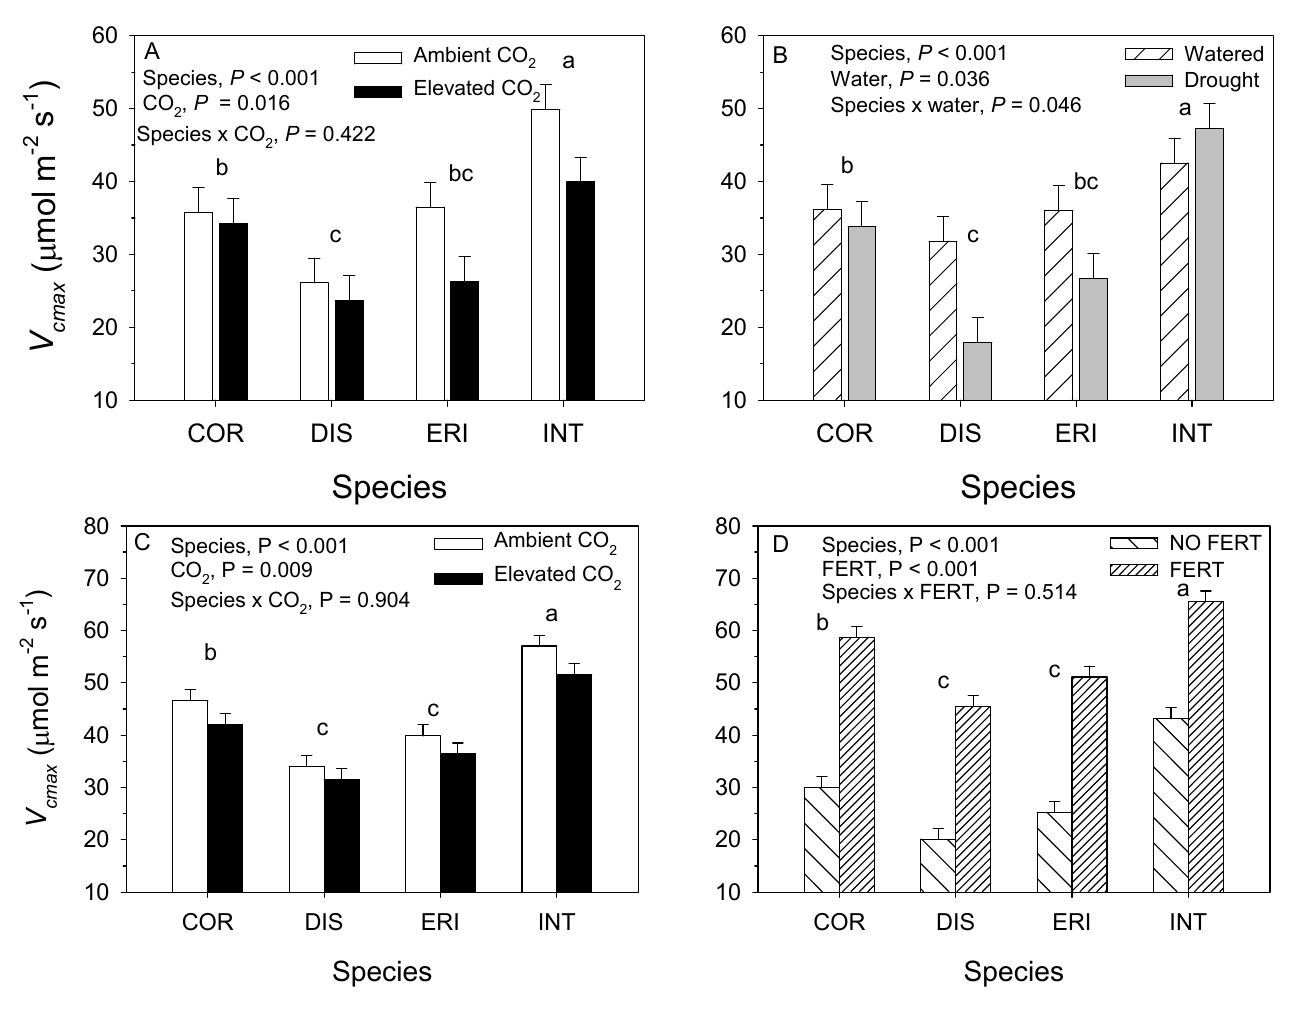
Figure 1. ( A ) Maximum rate of carboxylation ( V cmax ) (mean ± SE) by willow species and CO 2 treatments in 2017, ( B ) by willow species and moisture stress treatments in 2017, ( C ) by willow species and CO 2 treatments in 2018, and ( D ) by willow species and fertilization treatments in 2018. If lower case letters differ among willow species than significantly different using Tukey’s mean separation test ( p = 0.05). Table 2. Assimilation to internal CO 2 traits and ANOVAs from the CO 2 × moisture stress treatment experiment, 2017, including source of variation, degrees of freedom (df), mean square values (MS), variance components (VC), p -values, and coefficient of determination (R 2 ). p -values < 0.05 are in bold print.